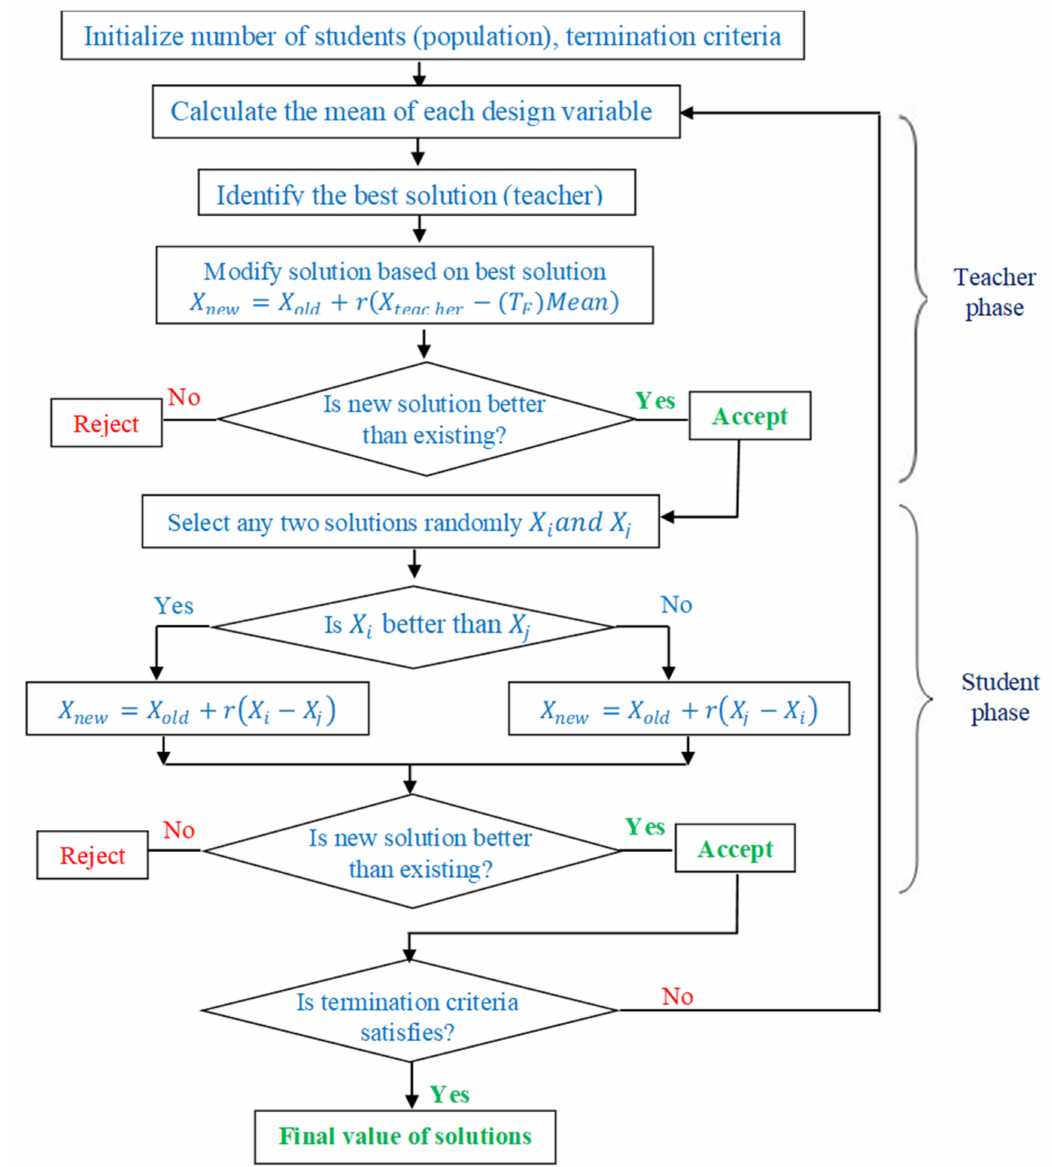
Figure 3. Methodology for implementation of TLBO